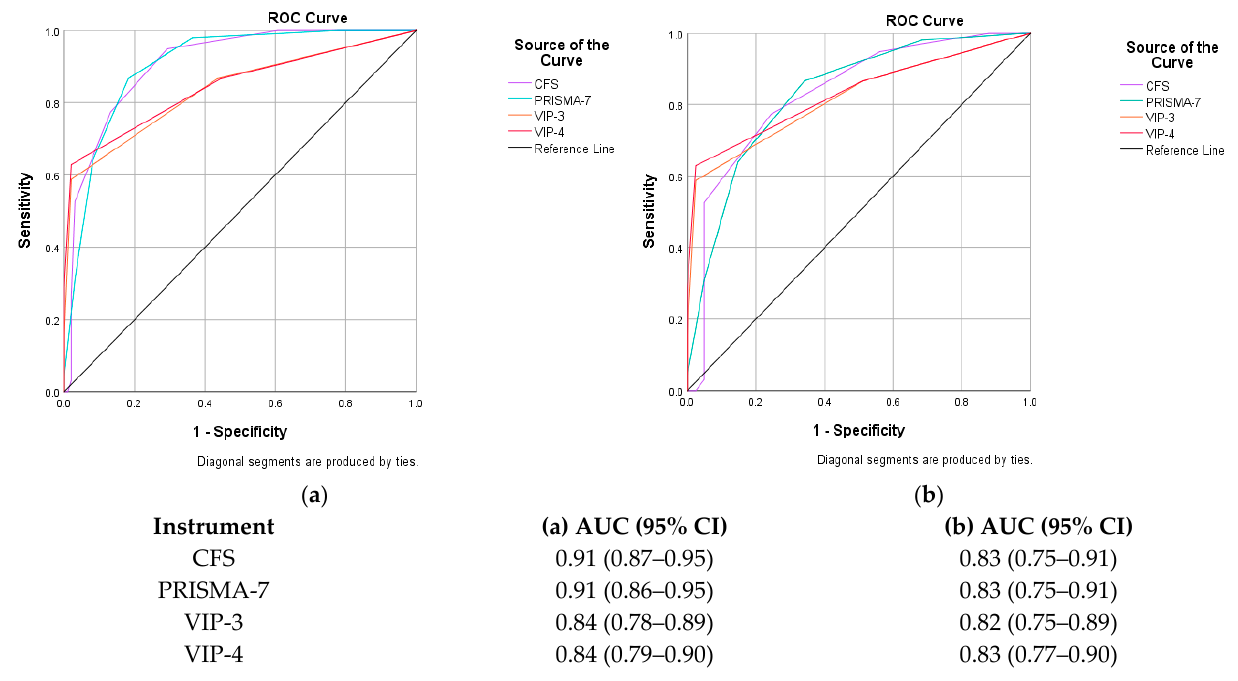
Figure 1. Receiver operating characteristic curves with area under the curve scores showing the accuracy (area under the curve) of the Clinical Frailty Scale (CFS), FRAIL scale, Groningen Frailty Index (GFI), Programme of Research to Integrate Services for the Maintenance of Autonomy 7 (PRISMA-7) tool, three-item Variable Indicative of Placement risk (VIP-3) and the and the four-item Variable Indicative of Placement risk (VIP-4) in differentiating ( a ) frail from non-frail and ( b ) frail from pre-frail older adults in the Emergency Department (classification based on the comprehensive geriatric assessment). Table 3. Sensitivity, specificity, positive predictive value (PPV), negative predictive value (NPV), positive (PLR) and negative likelihood ratio (NLR) with 95% confidence intervals (CI), for the Clin- ical Frailty Scale (CFS), PRISMA-7 and the three and four-item versions of the Variable Indicative of Placement risk (VIP) in their ability to differentiate frail from non-frail based on an independent comprehensive geriatric assessment.